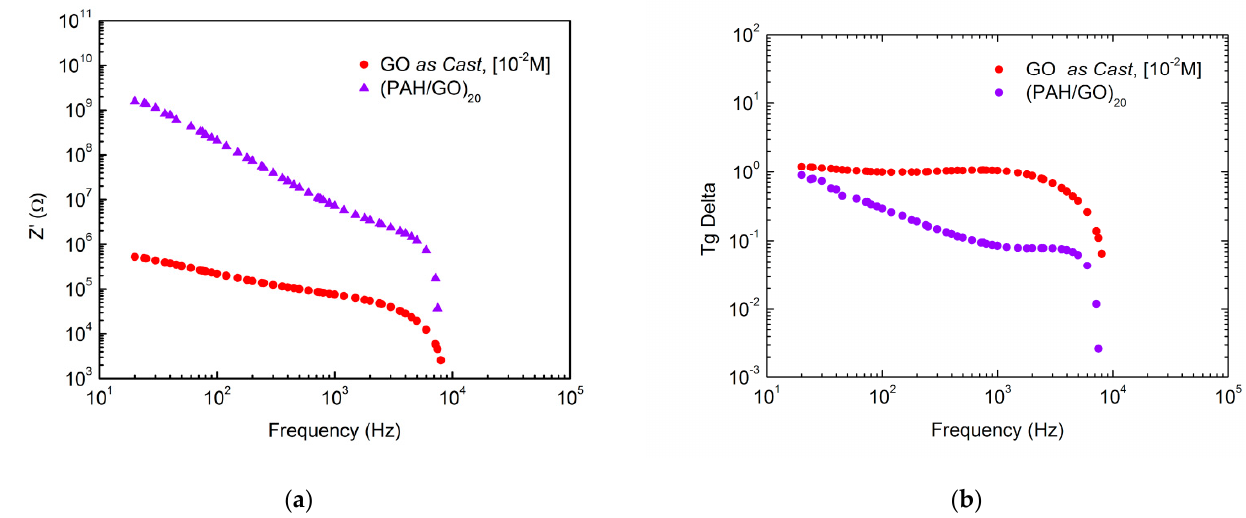
Figure 5. ( a ) Real impedance spectra and ( b ) tang delta spectra of PAH/GO LbL films and GO film in air at ambient conditions. Table 4. Attained values of the resistance and capacitance from fitting of Equation (1) to real impedance data of both